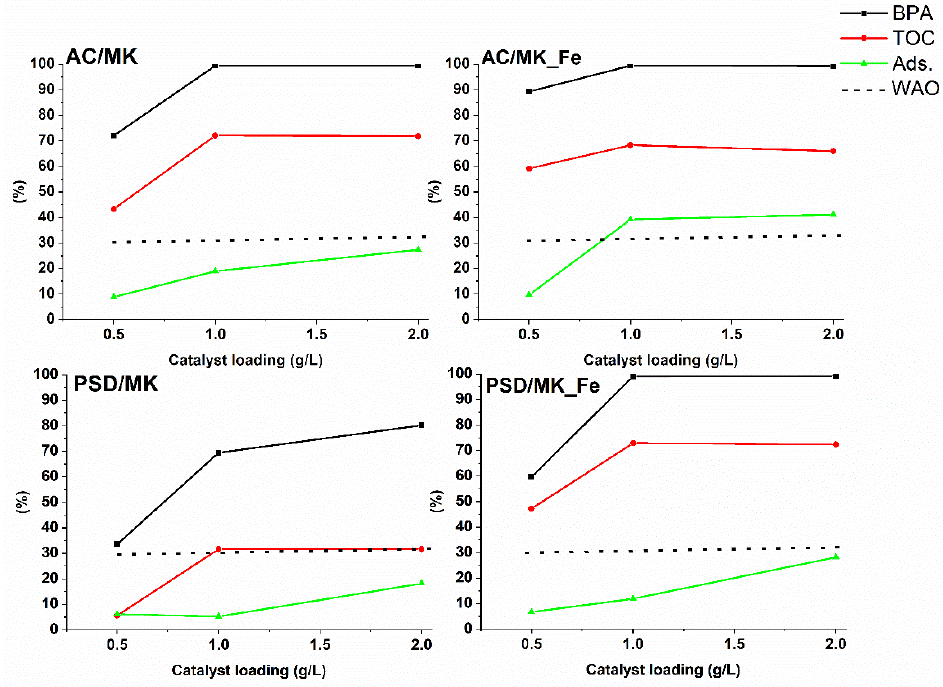
Figure 4. BPA and TOC conversions and BPA adsorption (Ads.) of AC/MK, AC/MK_Fe, PSD/MK, and PSD/MK_Fe catalysts with different catalyst loading. BPA and TOC conversions are presented at the reaction time 180 min and BPA adsorption after the heating period. The result of homogenous WAO is presented with a dashed line. Operating conditions: p (air): 20 bar, c (BPA): 60 mg/L, T: 160 °C, 800 rpm, pH initial 5 – 6. RSD ± 4%.